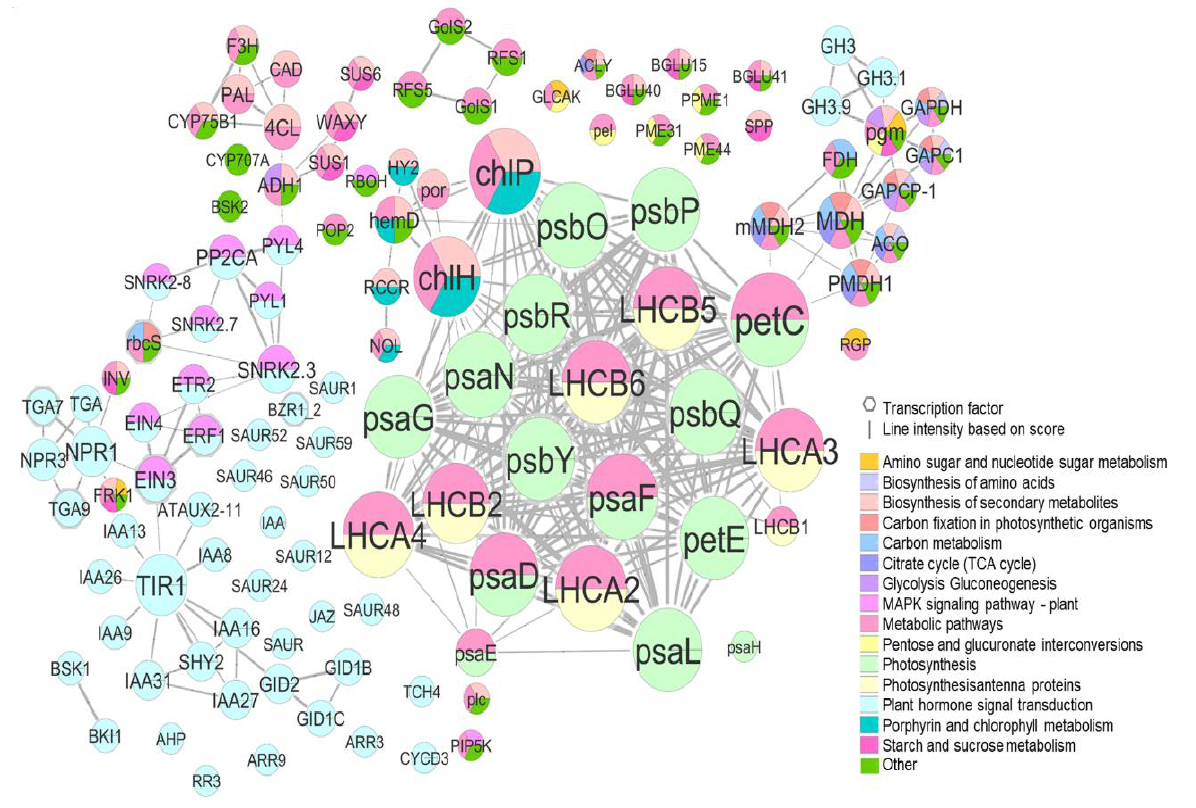
Figure 6. Protein – protein interaction network (PPI) of differentially expressed genes including the most DEGs common in both species (DEGs, − 1 > log2FC > 1; p -value < 0.005) and expressed genes interconnected between them in T1 vs. T2 comparison. The node represents the protein, the size of the node is proportional to the number of proteins that interact, and the interaction with a score >0.6 were chosen for analysis.